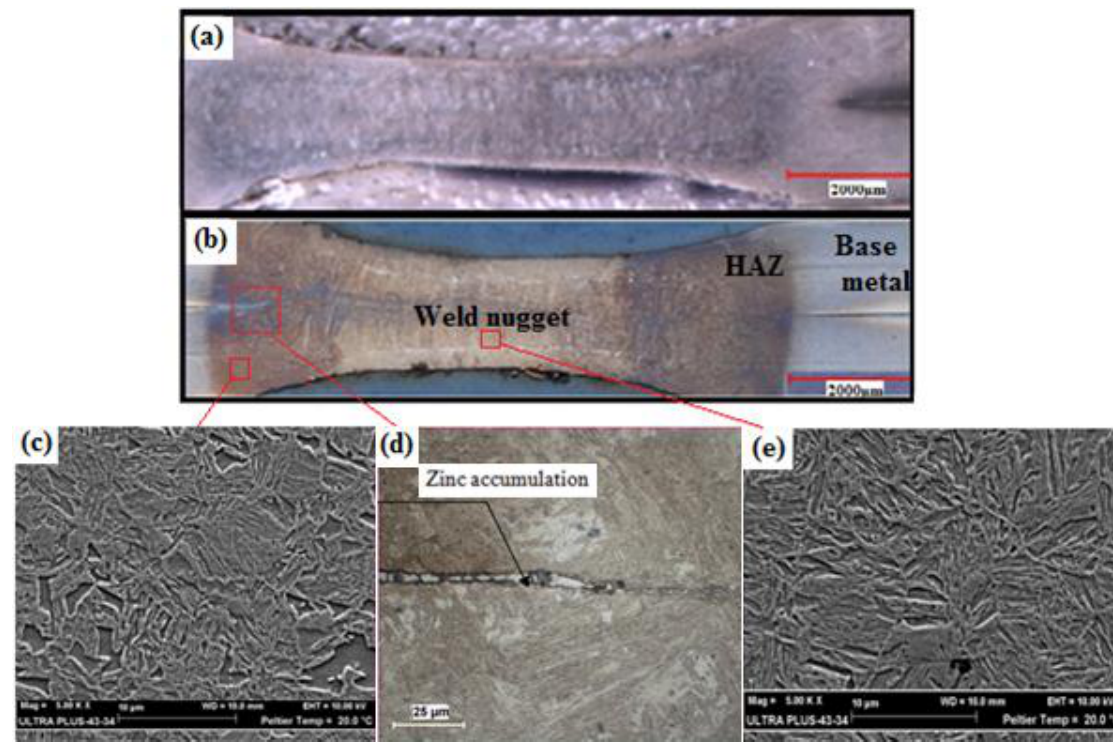
Figure 3. Macro and microstructure of spot-welded samples: ( a ) uncoated; ( b ) galvanized; ( c ) HAZ; ( d ) periphery of contact zone; ( e ) weld nugget.